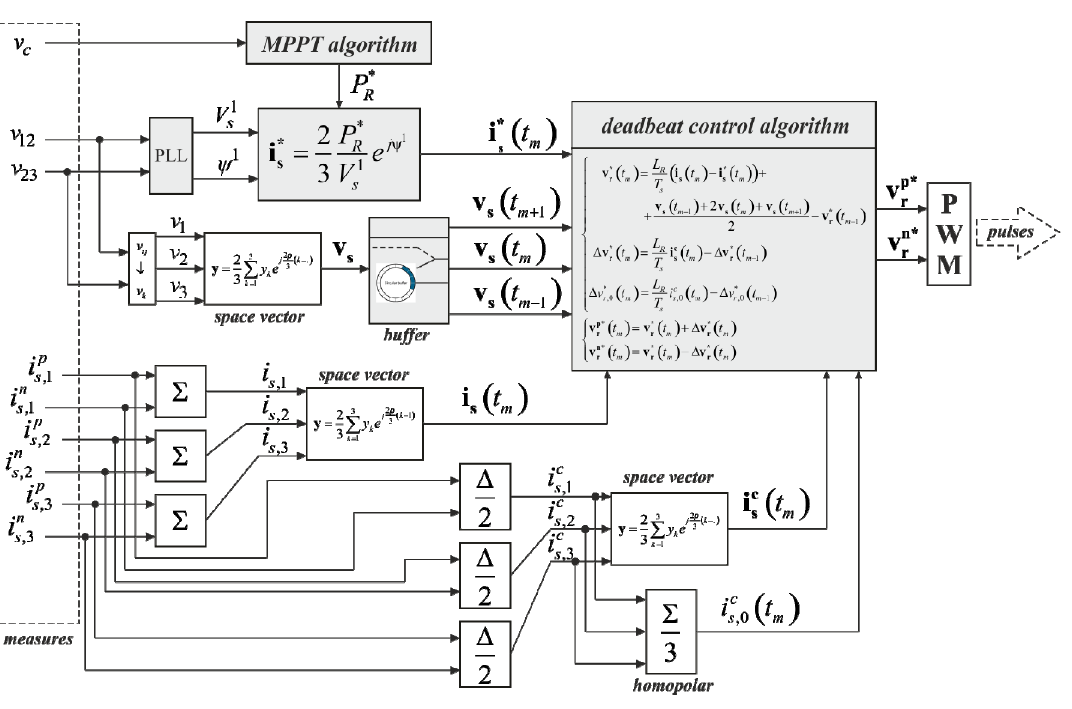
Table 2. Main parameters of the system.